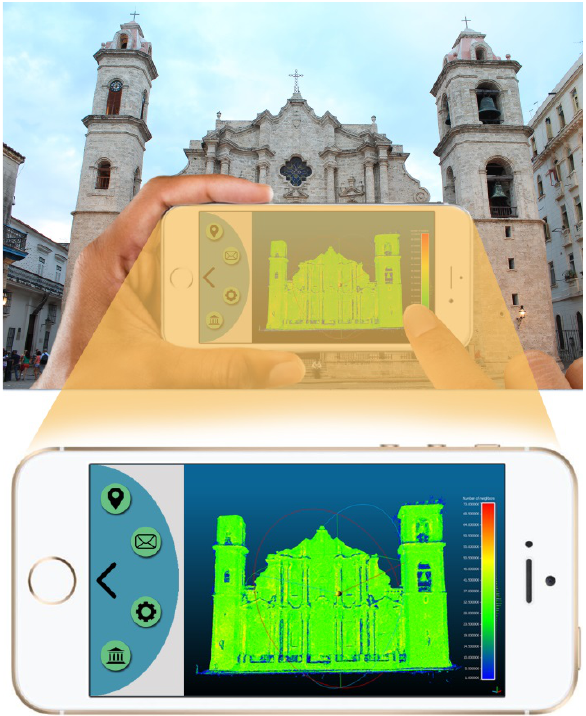
Figure 15. Example of an application of aumented reality (Catedral de la Virgen Maria de la Conceptión Inmaculada - Plaza de la Catedral)